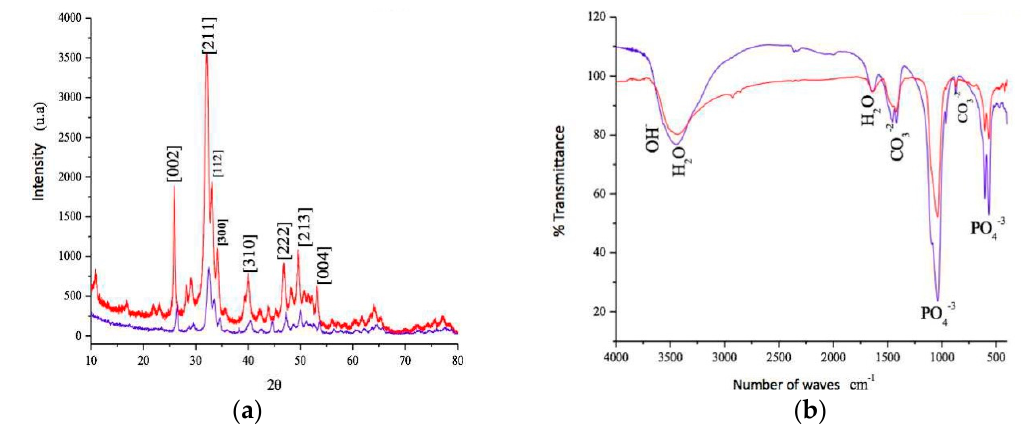
Figure 2. ( a ) X-ray di ff raction patterns (XDR) of CHA (red line) and Bio-Oss ® (blue line) samples show typical peaks of hydroxyapatite ( b ) Fourier transformed infrared spectra (FTIR) of CHA (red line) and Bio-Oss ® (blue line) samples show phosphate bands of hydroxyapatite at 1038, 960, 602 and 560 cm − 1 and strong carbonate bands in the 1414–1462 cm − 1 region, due the PO 43 − for CO 32 − substitution.